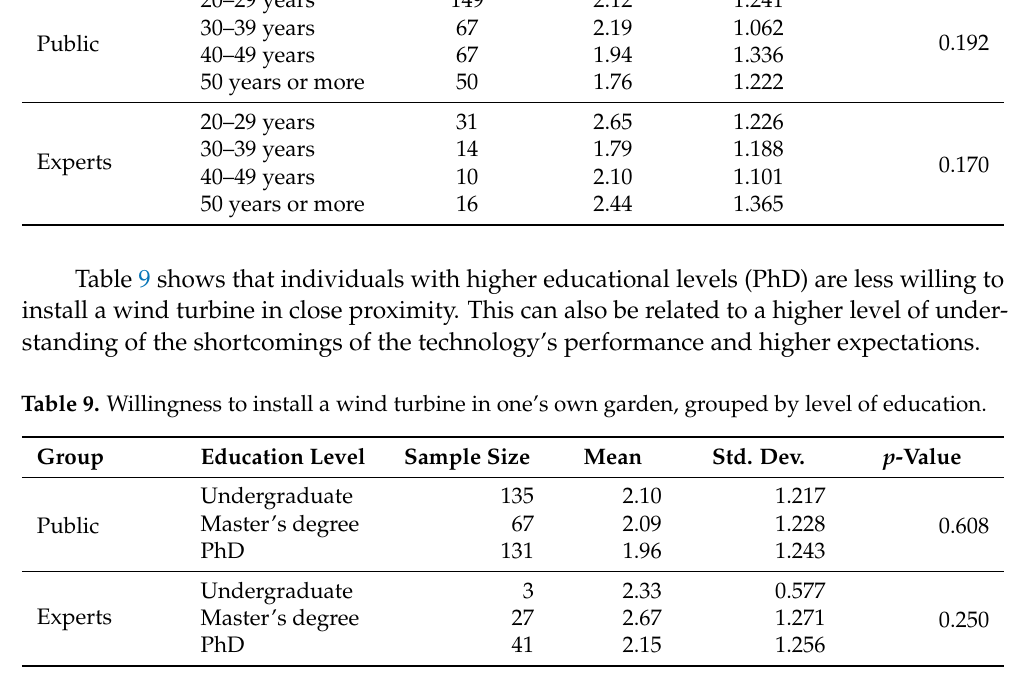
Table 8. Willingness to install a wind turbine in one’s own garden, grouped by age. Group